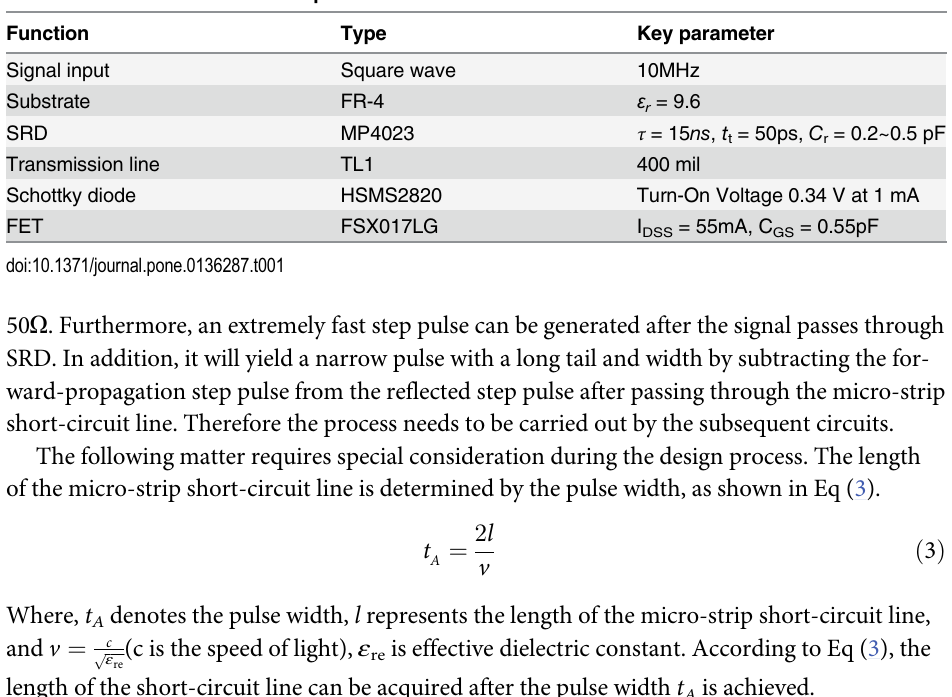
Table 1. Parameters of main components of